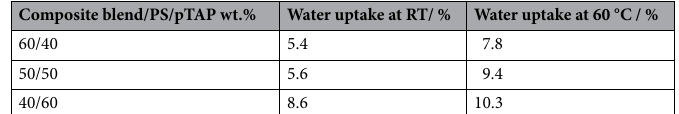
Composite blend/PS/pTAP wt.%